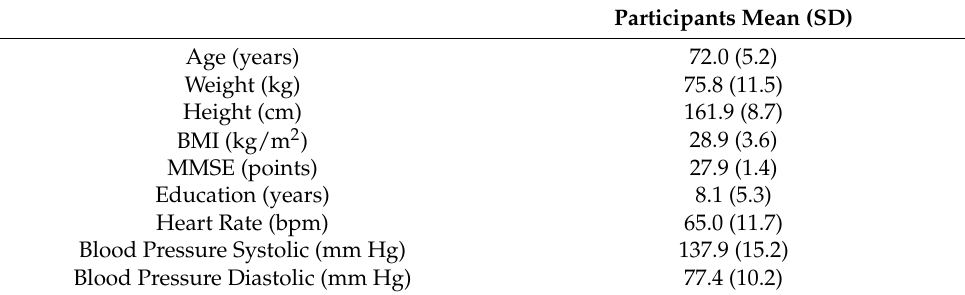
Table 1. Descriptive characteristics of the